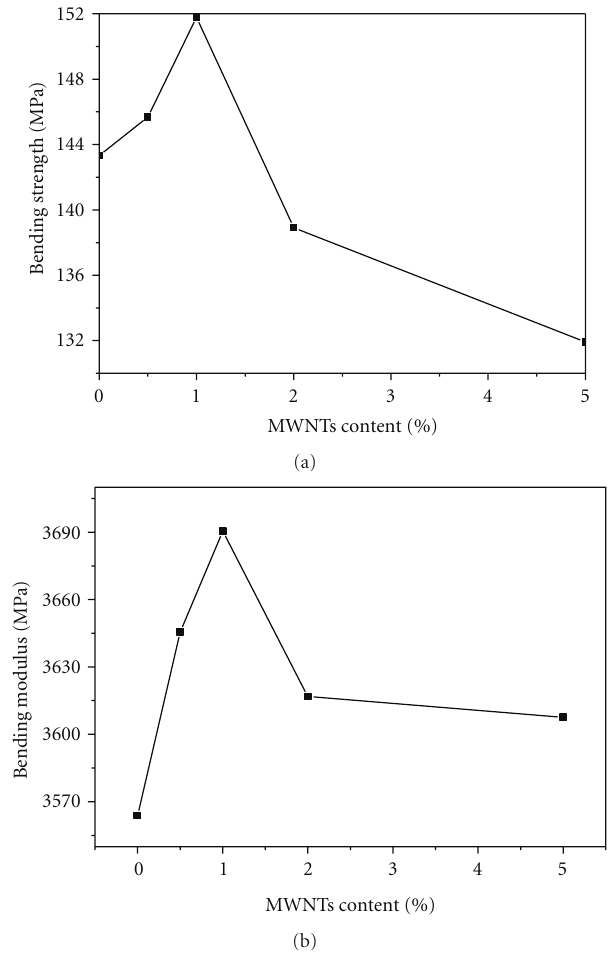
Figure 3: The influence of MWNTS OH on flexural properties of nanocomposites ((a) bending strength, (b) bending modulus).